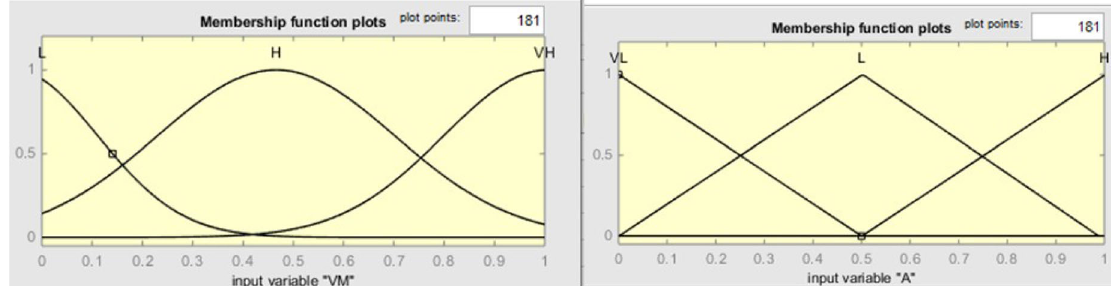
Fig. 6 Membership function plots for the input variables